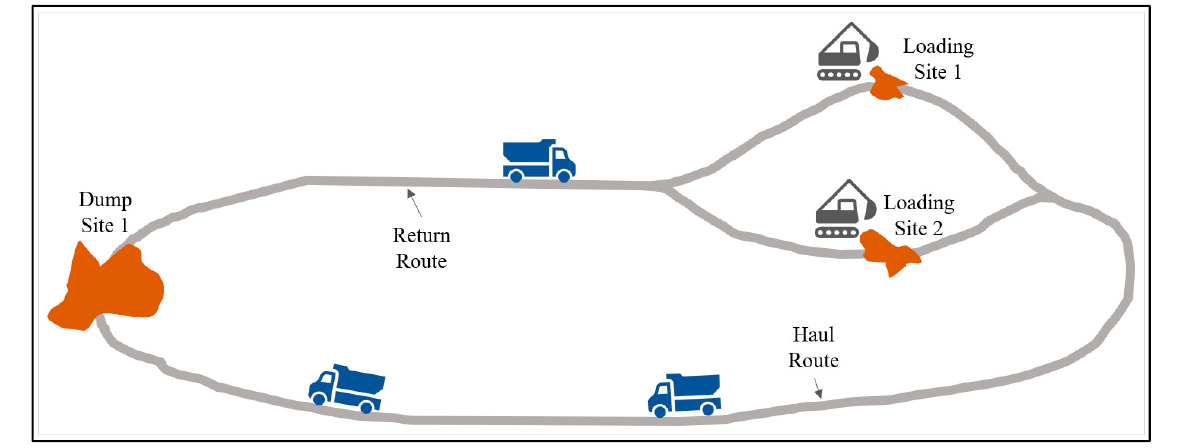
Figure 5. Schematic layout of the earthmoving site.